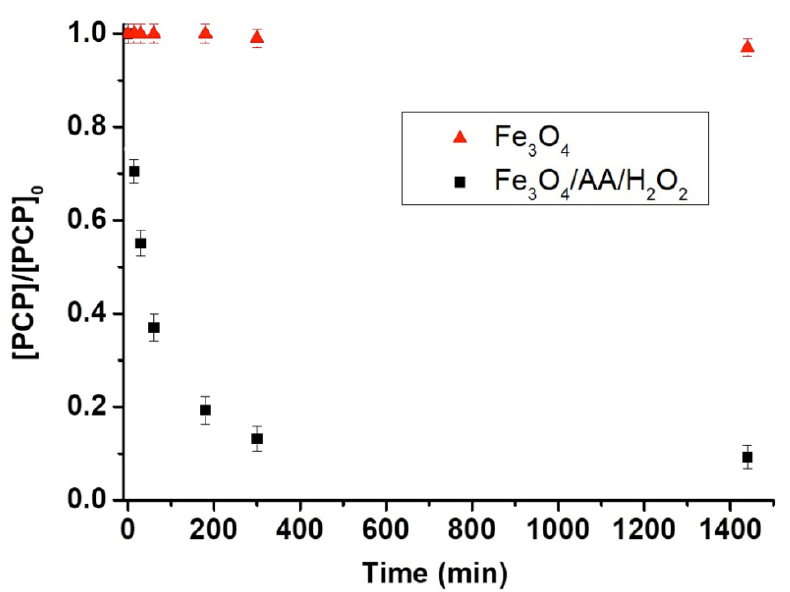
Figure 4. PCP degradation in contaminated soil using Fe 3 O 4 alone and Fe 3 O 3 /AA/H 2 O 2 . [PCP] represents the PCP concentration at a specified oxidation time and [PCP] 0 is its concentration at t = 0 (before treatment) determined by HPLC. Experimental conditions are: Fe 3 O 3 = 5 g kg − 1 soil w/w, AA = 50 mM, H 2 O 2 = 200 mM, liquid-to-solid ratio (L/S) = 1, total solution volume = 2 mL, and initial pH = 7.2.